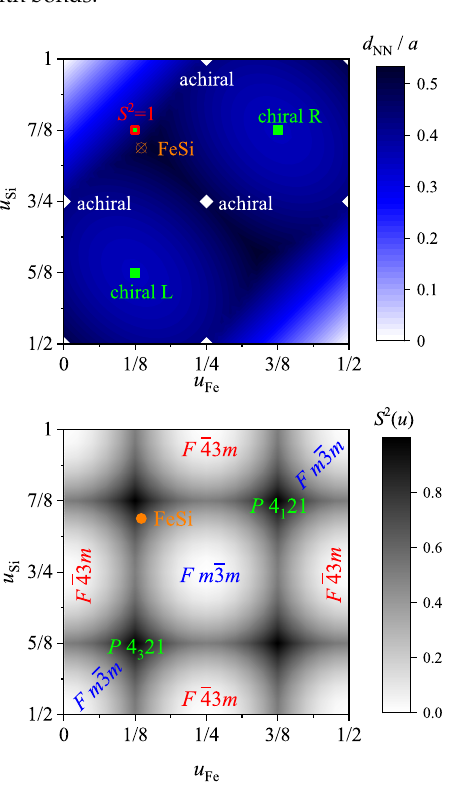
Figure 7. Chirality and nearest neighbor distances of the compounds with FeSi structure. Shown are on top the nearest neighbor distances and on the bottom the continuous chirality measure S 2 ( u TM , u MG ) for space group 198 with two 4a Wyckoff positions occupied ( B 20 compounds). The values for FeSi (LR), the space groups of the achiral structures where S = 0, or the chiral space groups where S = 1 are assigned in the graph. Important note: The borderline parameters ( u TM , u MG ) = ( 0,1 ) , and ( 1/2,1/2 ) are not possible as is evident from the graph of the nearest neighbor distances. Note that the largest possible nearest neighbor distance in B 20 compounds is d NN,max / a =